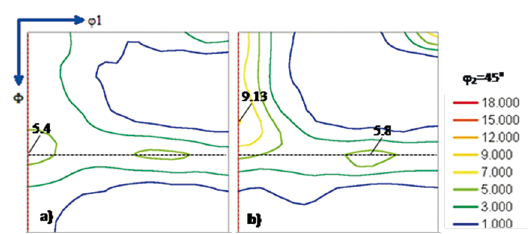
Figure 4. Macro-texture after 60% cold rolling: a) near the surface after the first reduction; b) center after the first reduction; ϕ ODF section.